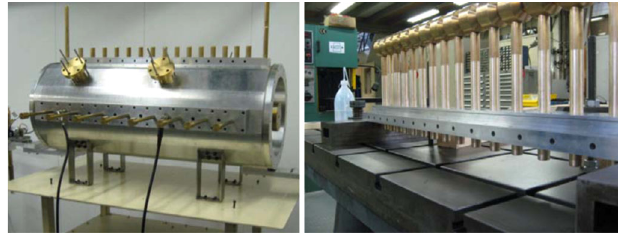
FIG. 22. DTL cold model at CERN and a view of the drift tubes in the alignment